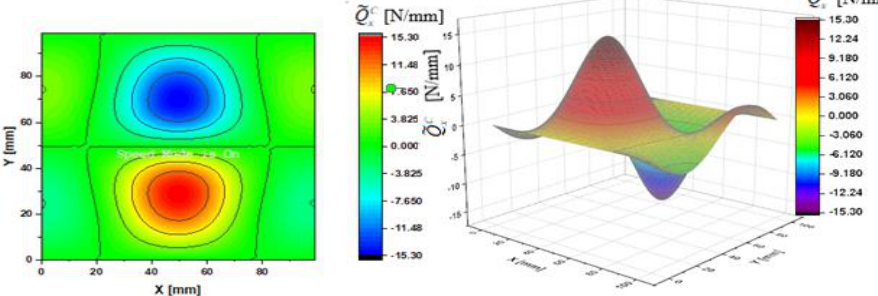
Figure 6. Contour-plane chart of (cid:101) Q C x for Case A.